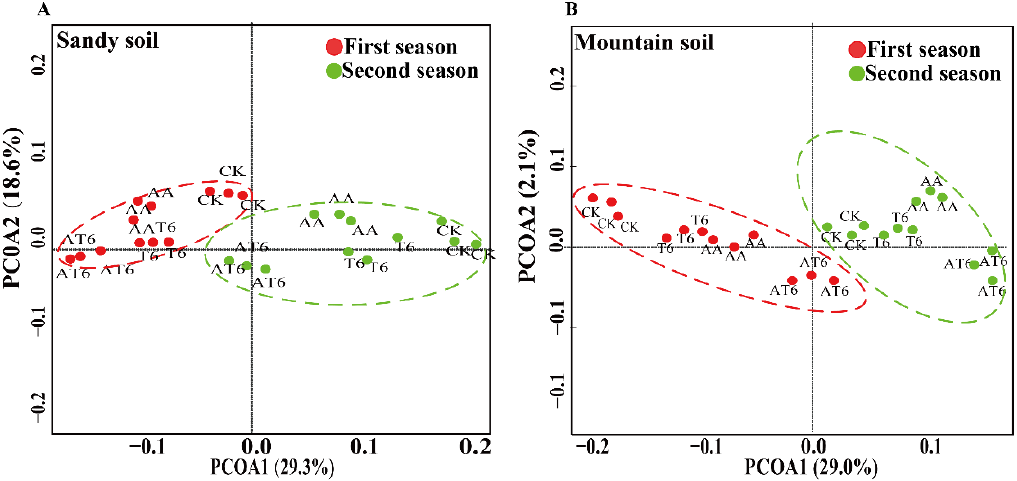
Figure 7. The PCoA analysis of different treatments in sandy and mountain soil during two growth seasons. ( A ) the results obtained in sandy soil, ( B ) the results obtained in mountain soil.